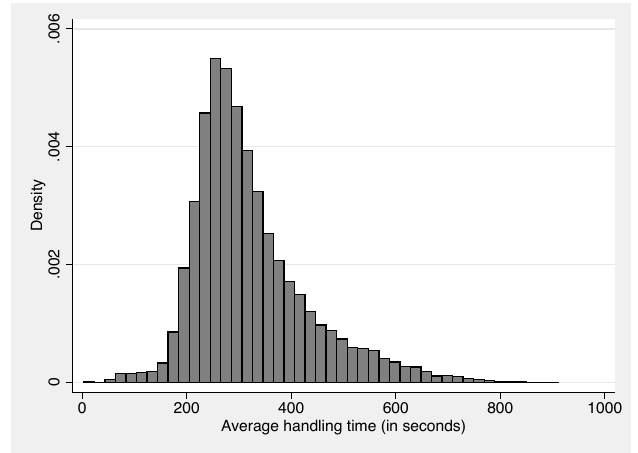
Figure 1: Density of daily productivity